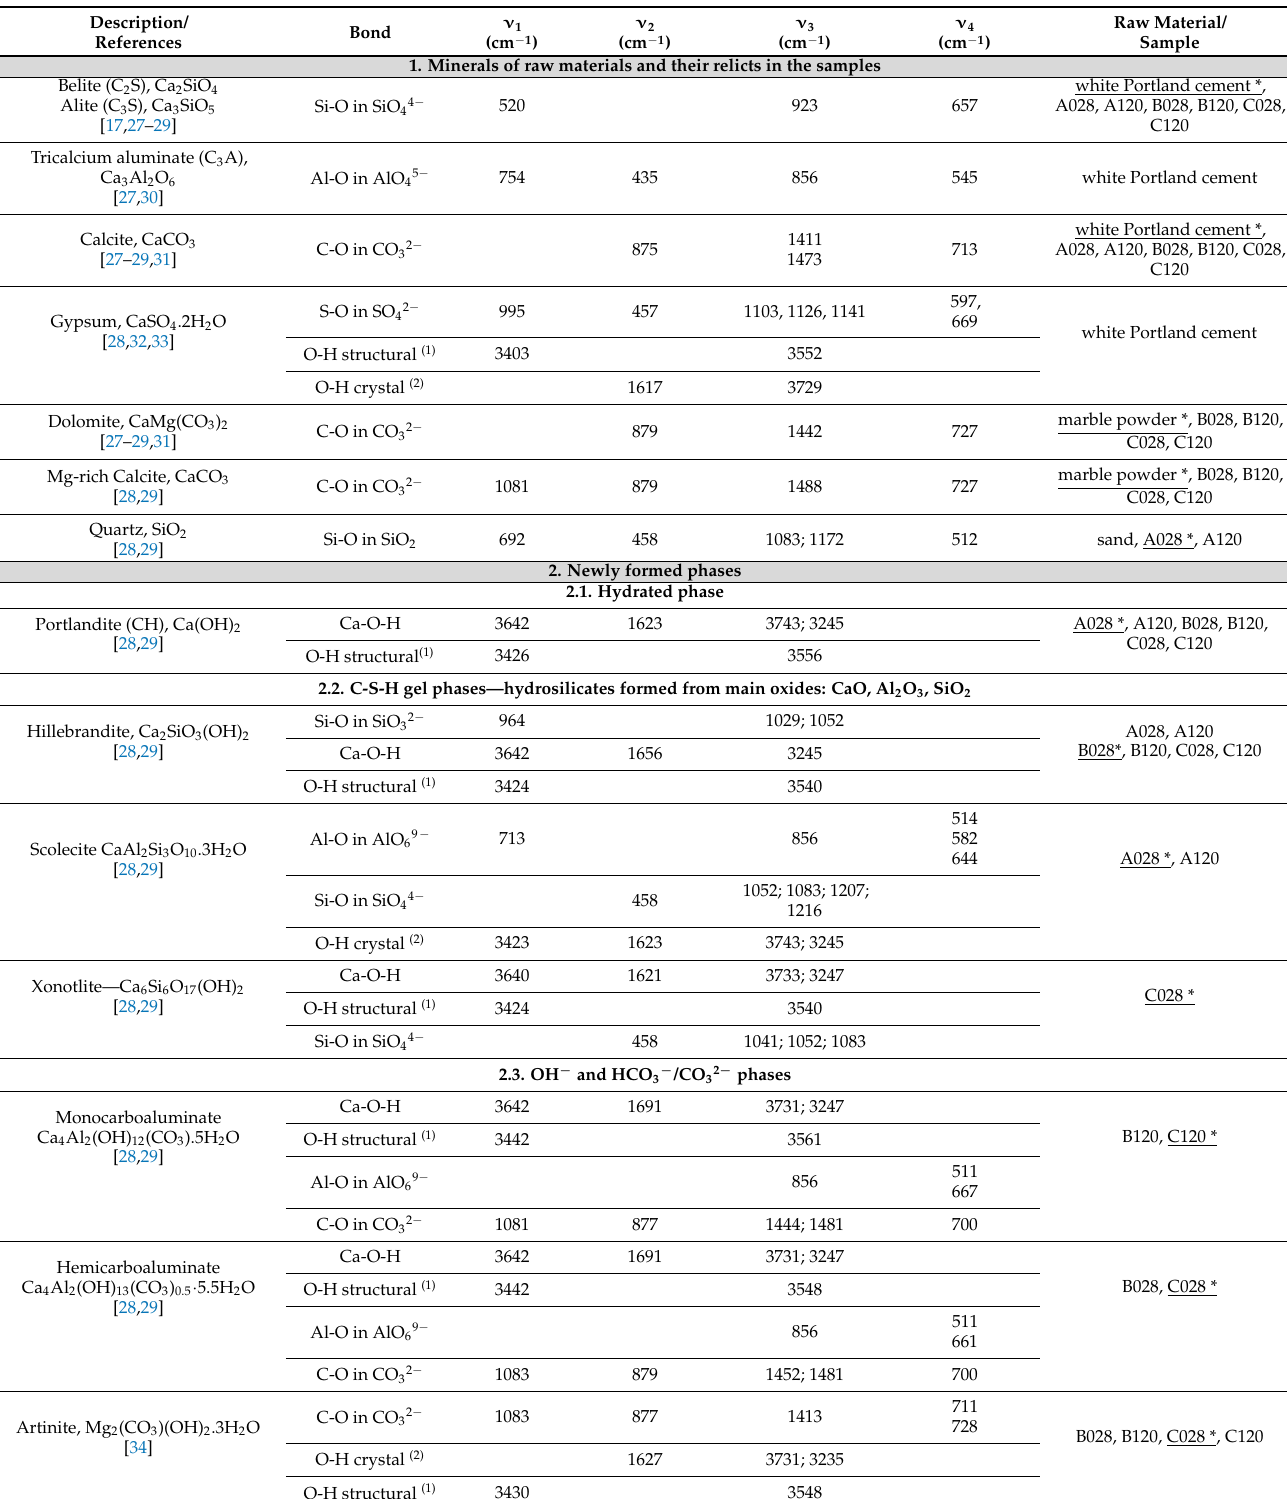
Table 5. Results from FTIR spectroscopy of raw materials (white Portland cement and marble powder) and A028, A120, B028, B120, C028, and